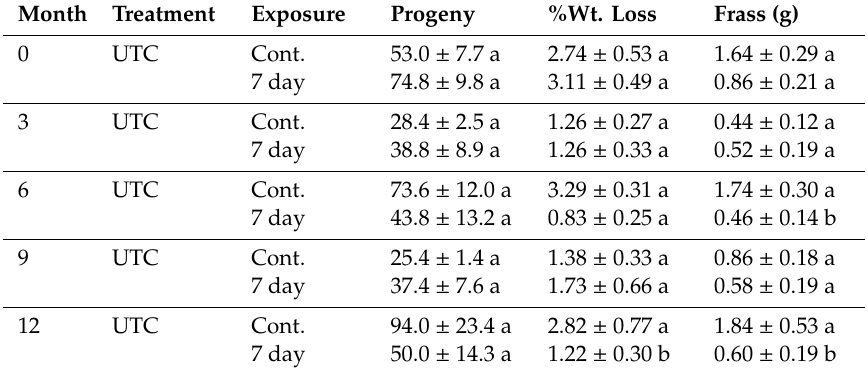
Table 14. Number of F 1 adult progeny, % of sample weight loss due to insect feeding, and feeding damage (frass) (mean ± SE for all) from exposure of ten mixed-sex parental adult R. dominica exposed continuously for about 8 weeks (Cont.) on ~80 g of untreated brown rice (UTC), or parental adults were removed after 1 week and samples were held for an additional 8 weeks (7 day). No progeny development on brown rice treated with low and high rates of Diacon IGR + or the Gravista formulation, no overall ANOVA done, only comparison between the two parental exposure regimes. Data are separated by month, bioassays were done at 1 day (month 0), and 3, 6, 9, and 12 months after treatment 1 .